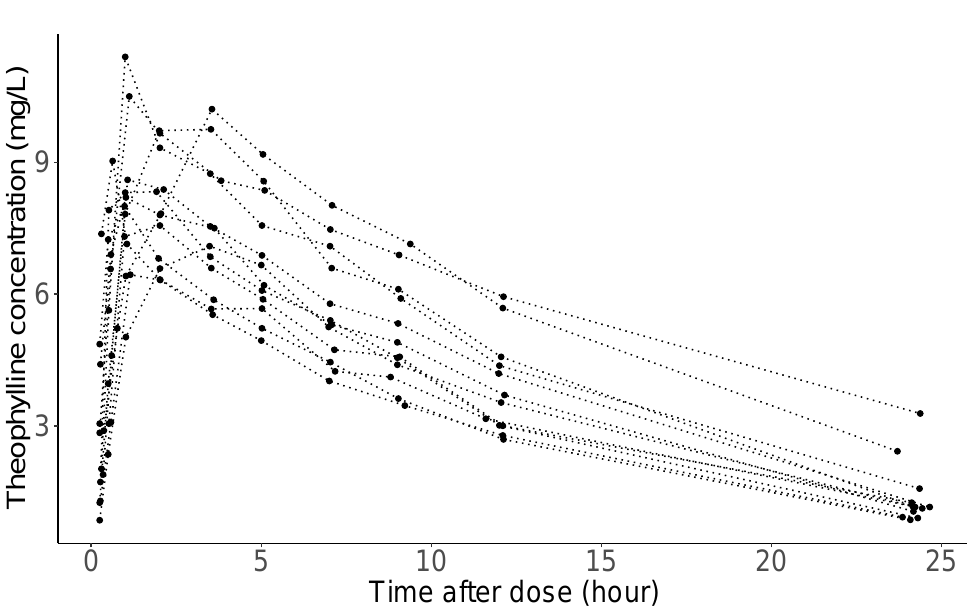
Figure 3. Theophylline concentrations for 12 subjects following an oral